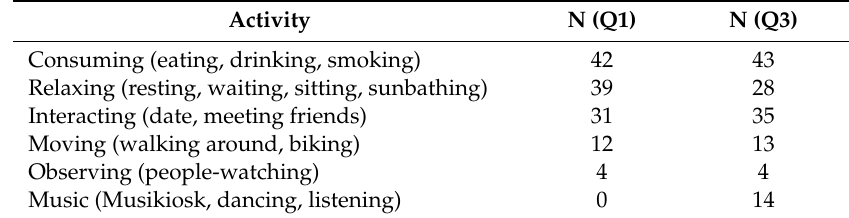
Table 2. Activity categorization before and after Musikiosk installation. Note: if people reported multiple activities, it was coded more than once. Activity N (Q1) N (Q3) Consuming (eating, drinking, smoking) 42 43 Relaxing (resting, waiting, sitting, sunbathing) 39 28 Interacting (date, meeting friends) 31 35 Moving (walking around, biking) 12 13 Observing (people-watching) 4 4 Music (Musikiosk, dancing, listening) 0